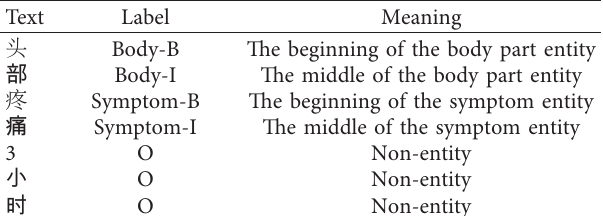
Table 2: BIO annotation example.